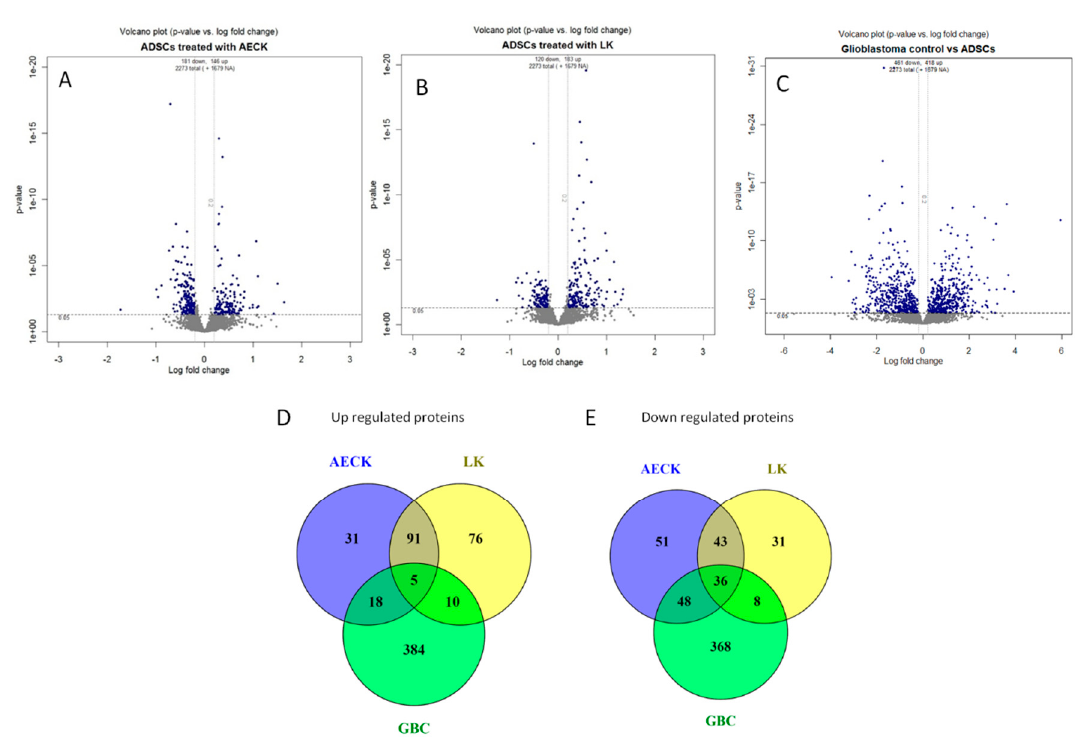
Figure 2. Volcano plots ( A – C ) showing p -values versus protein fold change (log2) of ADSCs and comparisons generated with DanteR. Quantitation criteria cutoff of statistically significant p -values < 0.05 and fold change log2 ratio cutoff of < − 0.2 or >0.2. The blue nodes represent the above >0 log fold change, i.e., up-regulated proteins and the below <0 fold change down-regulated proteins. The grey nodes represent the not significantly changed proteins with a p -value > 0.05 and within the cut off for fold change. ( D , E ) Three-way Venn diagrams of up and down regulated proteins. Diagrams include the AECK treated, LK treated hADSCs, and the GBCs showing unique and shared proteins. ( D ) up regulated proteins revealing there are 31, 76, 384 with 91, 10, 18 shared proteins between each of the corresponding tested cell lines as well as 5 shared proteins between all three relative to basal hADSCs. ( E ) down regulated proteins revealing there are 51, 31, and 368 unique proteins with 43, 8, and 48 shared proteins between each of the corresponding tested cell lines as well as 36 shared proteins between all three relative to basal hADSCs.